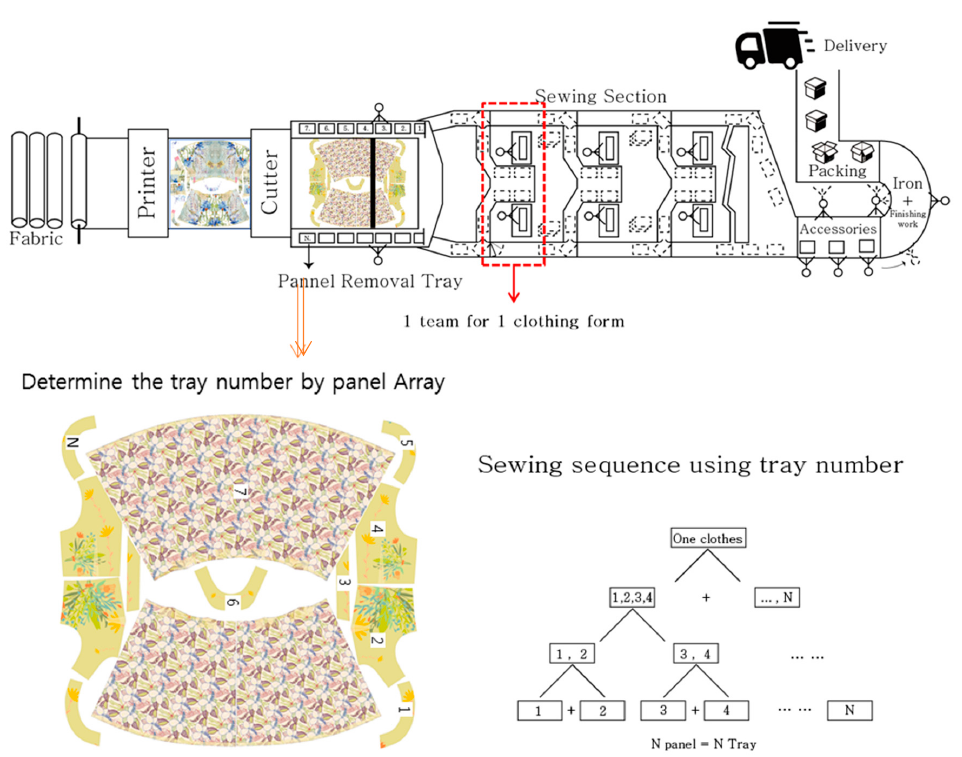
Figure 24. Design of smart factory for one person one item production.